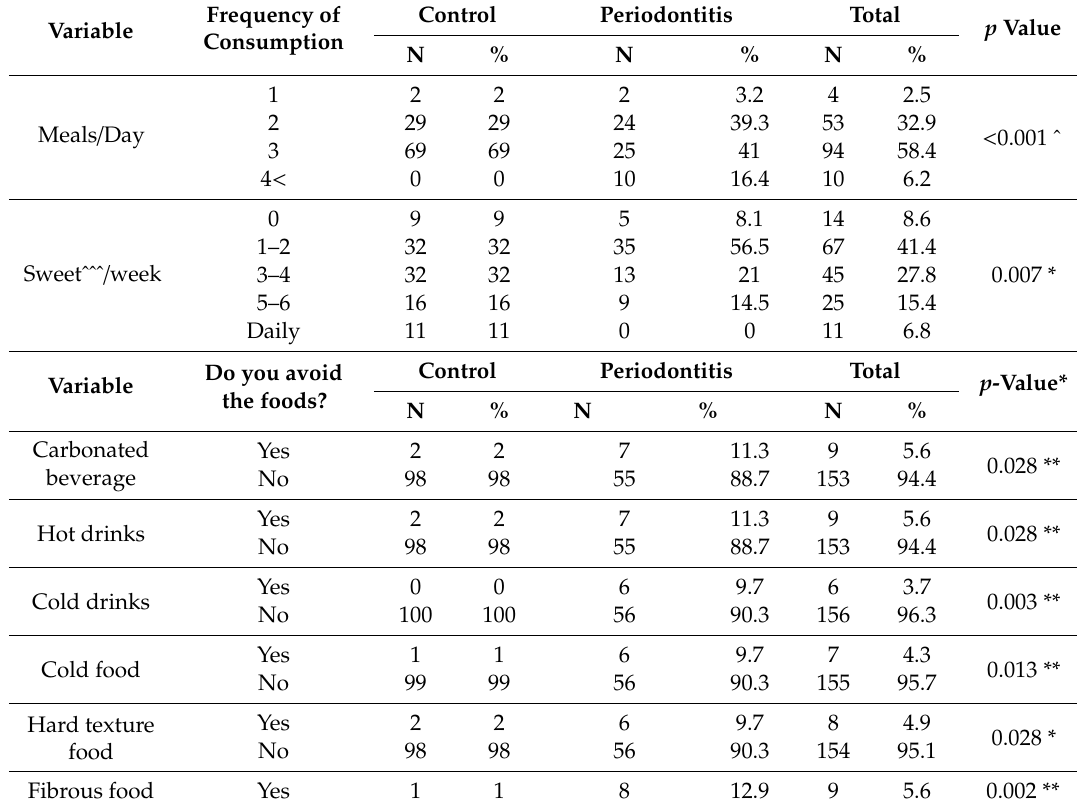
Table 3. Frequency of consumption and avoidance patterns of specific food groups among the study population * Pearson Chi-square, ˆ likelihood ratio ** Fisher’s exact